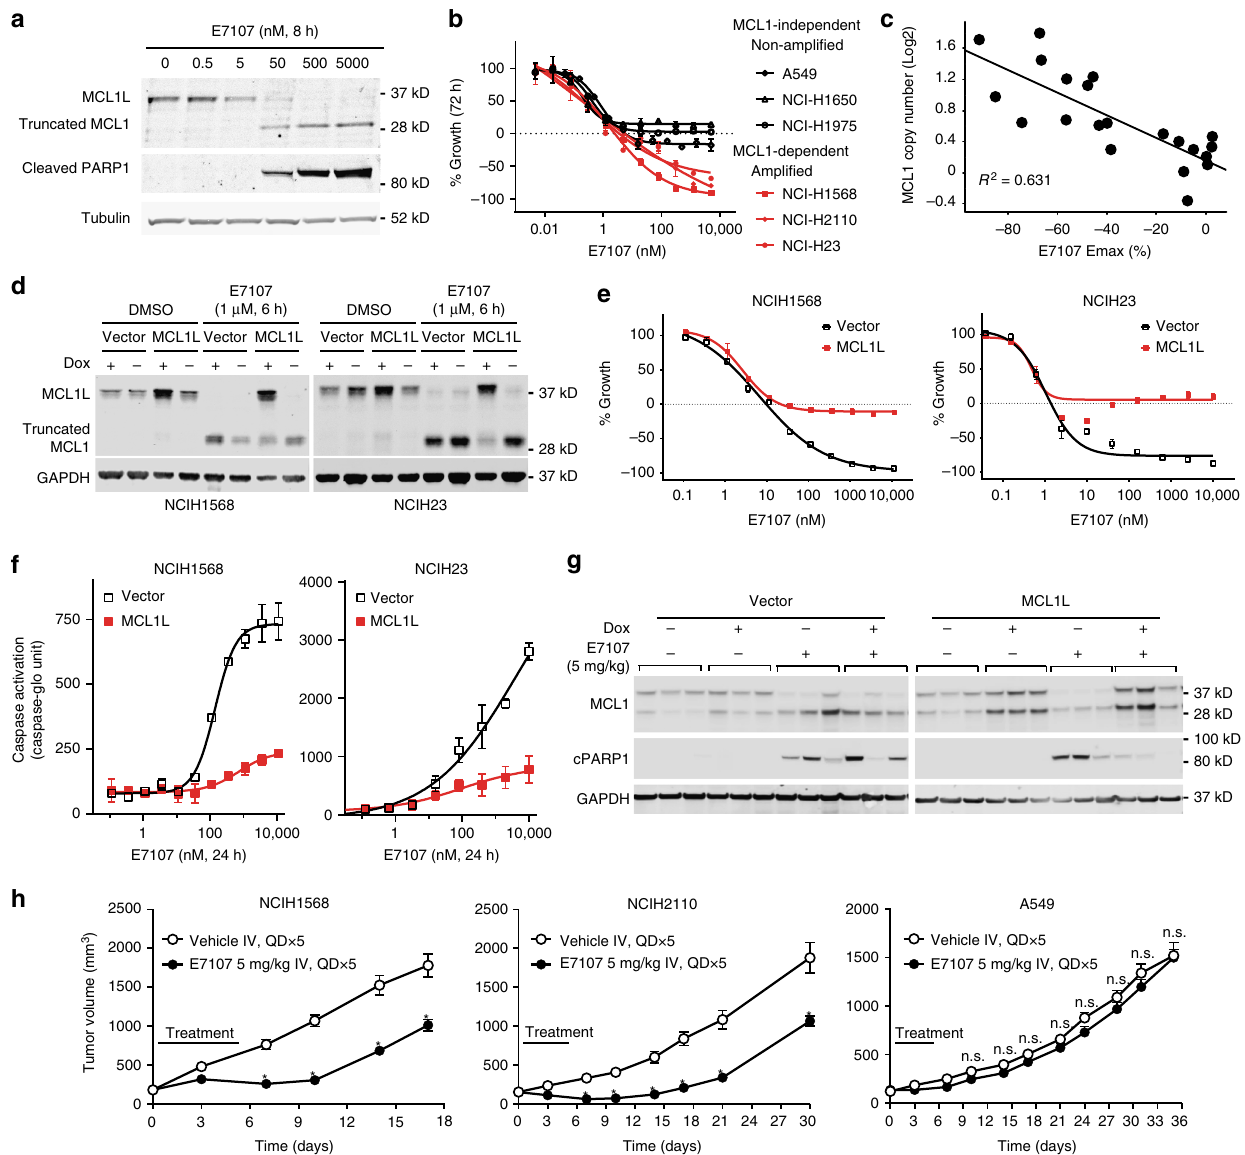
Fig. 5 E7107 induces MCL1-dependent apoptosis in MCL1-overexpressed/dependent NSCLC cells. a Western blot analysis of MCL1 protein and cleaved PARP1 as an indicator as apoptosis. Tubulin was used as loading control. NCIH1568 cells were treated with E7107 as indicated. b Growth curves measured by CellTiter-Glo (CTG) in NSCLC cell lines. Data represent means± SD of biological triplicates. c Correlation of MCL1 copy number and E7107 Emax in 21 NSCLC cell lines. d Western blot analysis of MCL1 and GAPDH (loading control) protein expression in NSCLC cell lines transduced with vector control (Vector) or Dox-inducible expression of MCL1L cDNA (MCL1L). Cells were treated with DMSO or E7107 as indicated. e Growth curves measured by CellTiter-Glo (CTG); and f Caspase activation detected by Essen Biosciences IncuCyte Caspase-3/7 Green Apoptosis Assay. Data represent means ± SD of biological triplicates. NSCLC cell lines transduced with vector control (Vector) or Dox-inducible expression of MCL1L cDNA (MCL1L) in the presence of 300 ng ml − 1 Dox. Cells were treated with E7107 as indicated. g Western blot analysis of NCIH1568 xenograft tumor samples. The engineered cell lines from d were used for the in vivo studies. h Tumor growth curves measured by tumor volume of three NSCLC xenograft models treated with vehicle or E7107. H1568: 8 mice/group; H2110: 6 mice/group; A549: 8 mice/group. Statistical signi fi cance was analyzed by the Holm – Sidak method in Prism. Each row was analyzed individually, without assuming a consistent SD. * p < 0.001; n.s. not signi fi cant, p > 0.1 (navitoclax, BCLxL Ki ≤ 0.5 nM) 34 in MCL1-dependent NSCLC on the same target BCLxL to achieve the synergistic effect (Fig. 6a cell lines, showing that combination of two inhibitors led to and Supplementary Fig. 10, right panels). synergistic cytotoxic effect in a 8 × 8 dose matrix with large excess over the Loewe additivity models (NCIH23 synergy score = 50.8, BCLxL inhibitor would induce cytotoxicity in MCL1-independent NCIH2110 synergy score = 50.2, NCIH1568 synergy score = NSCLC cells, and to further con fi rm that BCLxL is the major 35.2; Fig. 6a and Supplementary Fig. 10, left panels). Importantly, shRNA depletion of BCLxL largely diminished this synergy inhibitor A1155463 (BCLxL Ki ≤ 0.01 nM) 35 for combination between E7107 and ABT263, suggesting that the genetic shRNA studies in the MCL1 low A549 cell line that is cytostatic to E7107 perturbation and pharmacological inhibitor (ABT263) impinged (Figs. 2d and 5b). Here, although E7107 potently induced splicing NATURE COMMUNICATIONS| (2019) 10:137